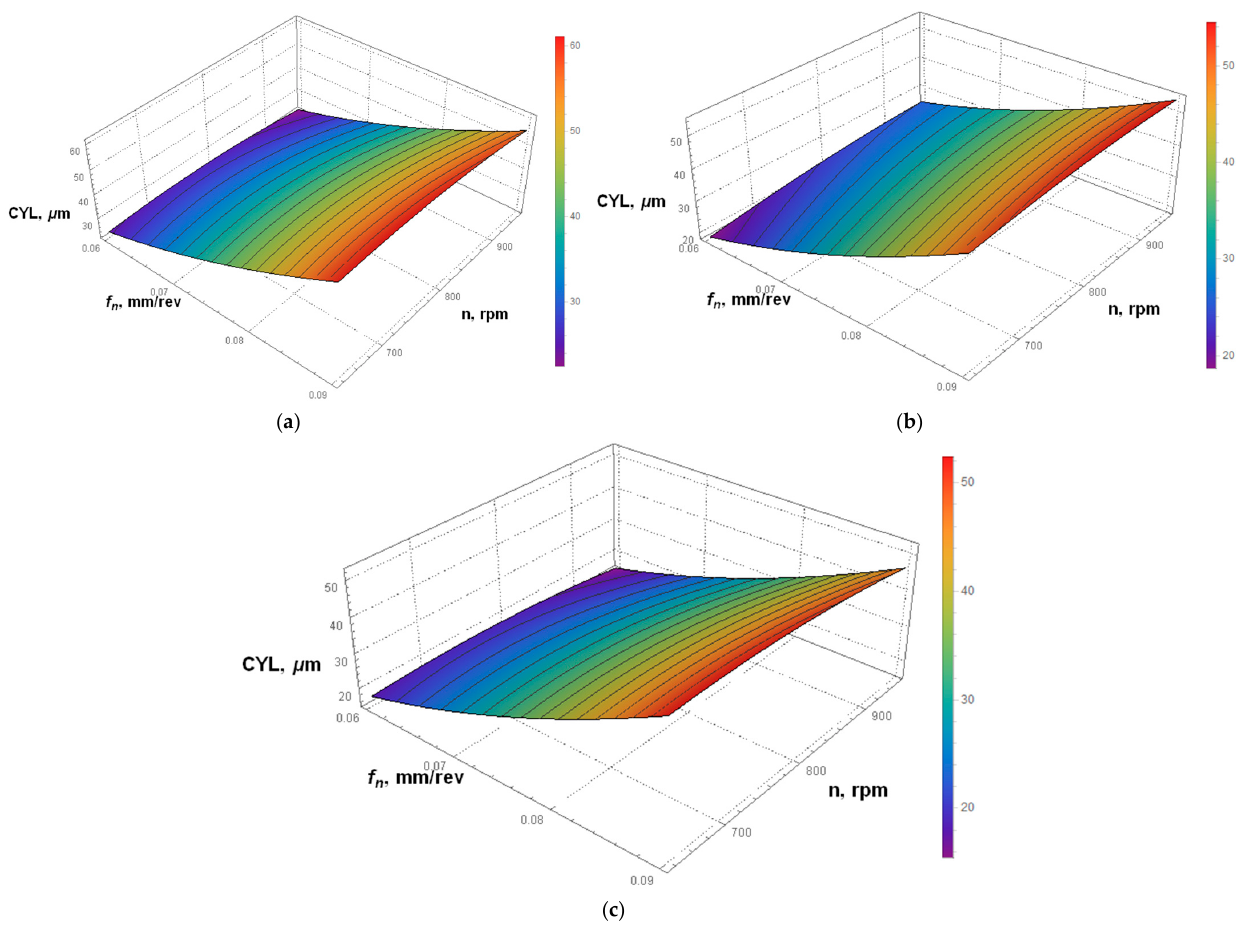
Figure 10. Simulations based on Equation (2); predictive modelling of the cylindricity error for: ( a ) the first kinematic system; ( b ) the second kinematic system; and ( c ) the third kinematic system.